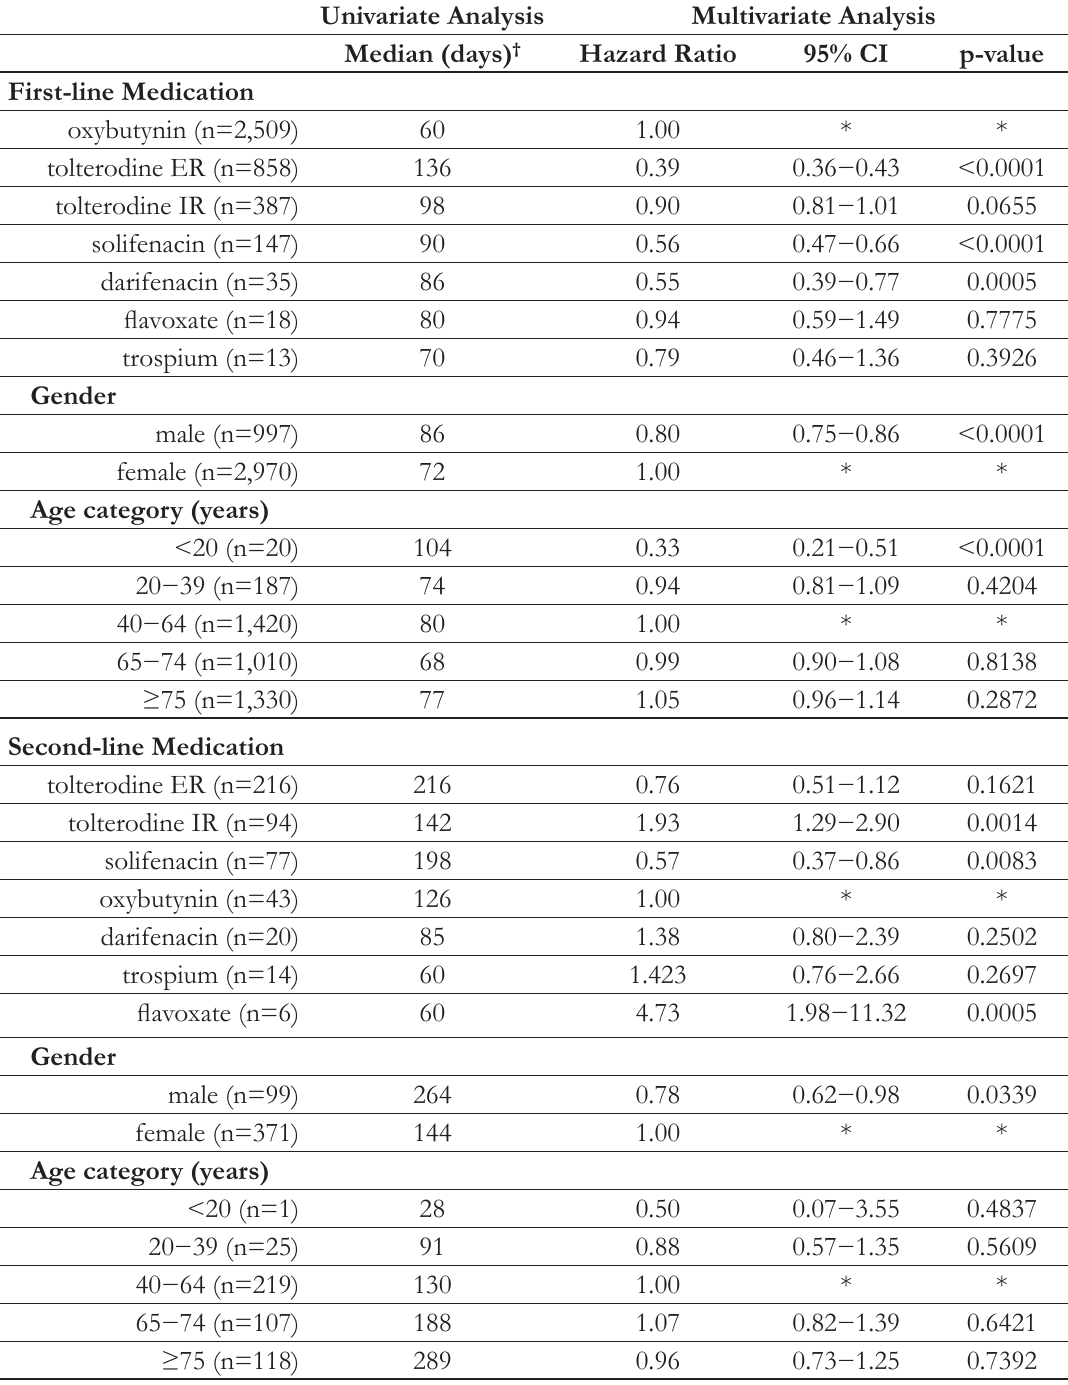
Table 3. Median Number of Days on First-line and Second-line Therapy and the Hazard Ratio for Risk of Switching, according to Antimuscarinic, Gender and Age